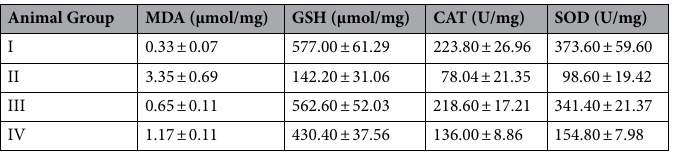
Table 4. Levels of skin oxidative stress biochemical markers on DMBA-induced skin carcinogenesis in mice (n =